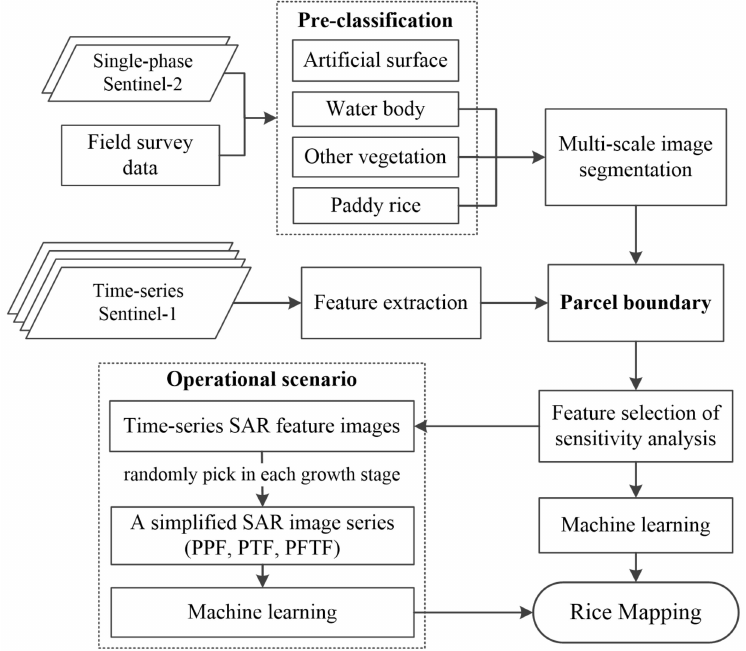
Figure 4. Illustration of the rice mapping method. PPF means the pure polarization feature set; PTF means the pure texture feature set; PFTF means the joint set of polarization features and texture